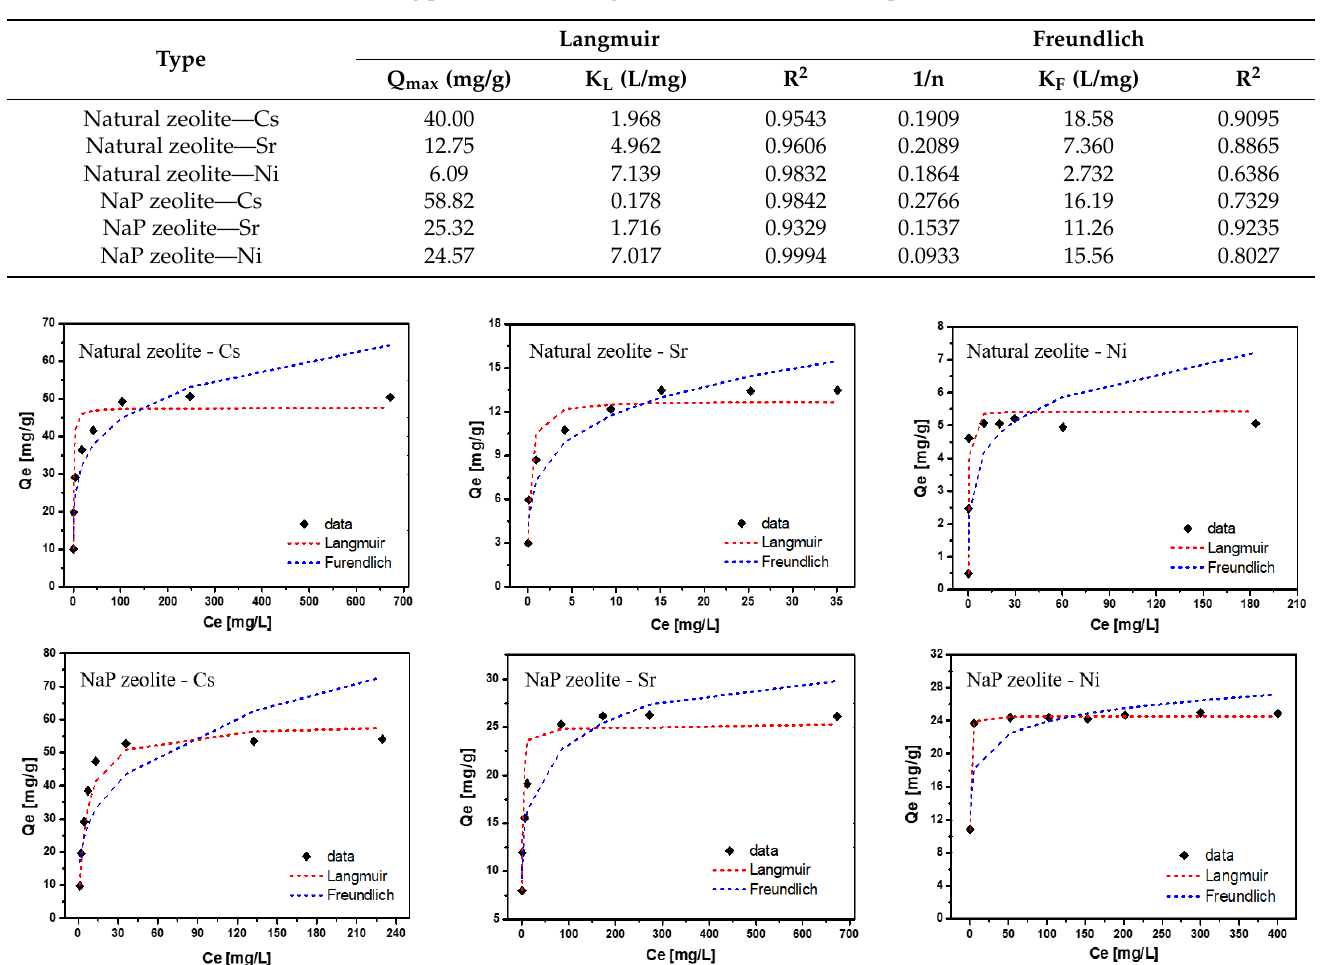
Figure 6. Adsorption isotherms for the removal of Cs, Sr, Ni on natural zeolite and NaP zeolite. (solid to solution ratio: 1 g/100 mL, batch sorption reaction time for equilibrium: 7 days). Table 3. Cation exchange capacity of natural zeolite and NaP zeolite .